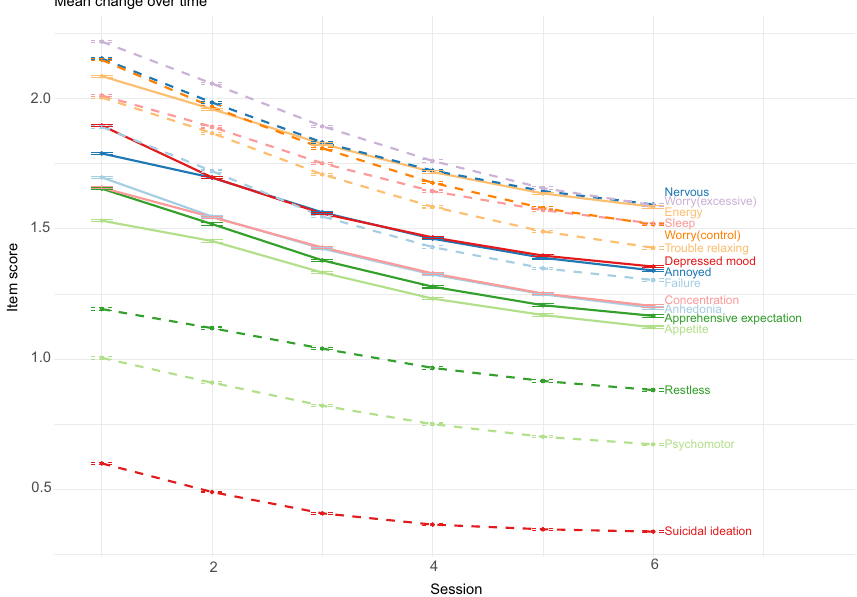
Figure 1. Mean symptoms scores (and standard error) across the six time points. Dashed lines are PHQ-9 items and solid lines are GAD-7